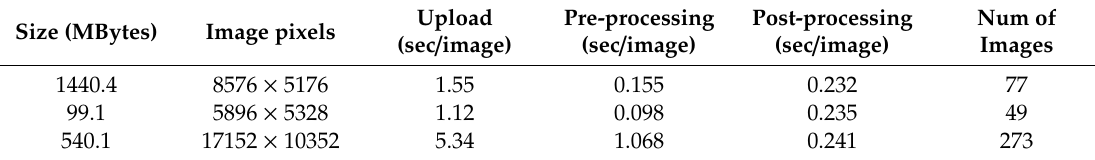
Table 6. The results of the system e ffi ciency test.